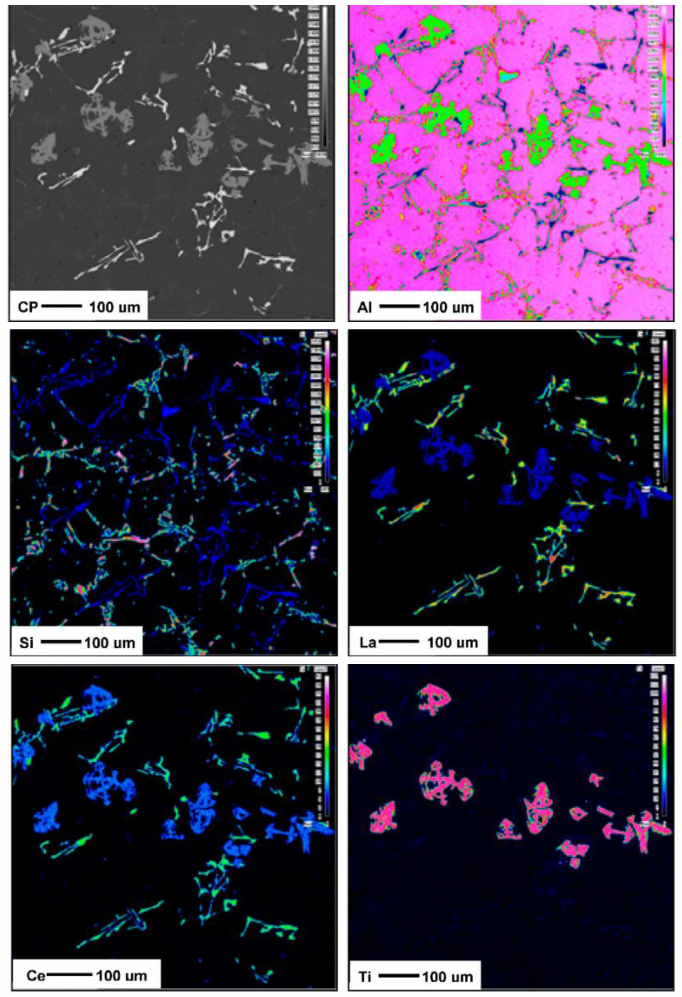
Figure 7. Backscattered electron (BSE) images showing the formation of La- and Ce-rich phases in an A356 alloy sample modified by the combination of 1% La and 1% Ce (T8 alloy) and the corresponding X -ray images of Al, Si, La, Ce and